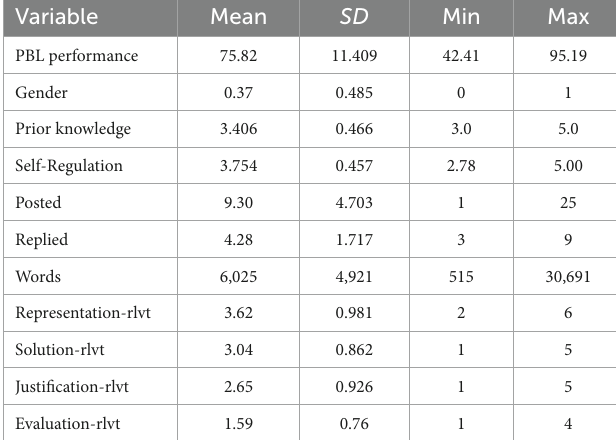
TABLE 2 Descriptive statistics of variables ( N =